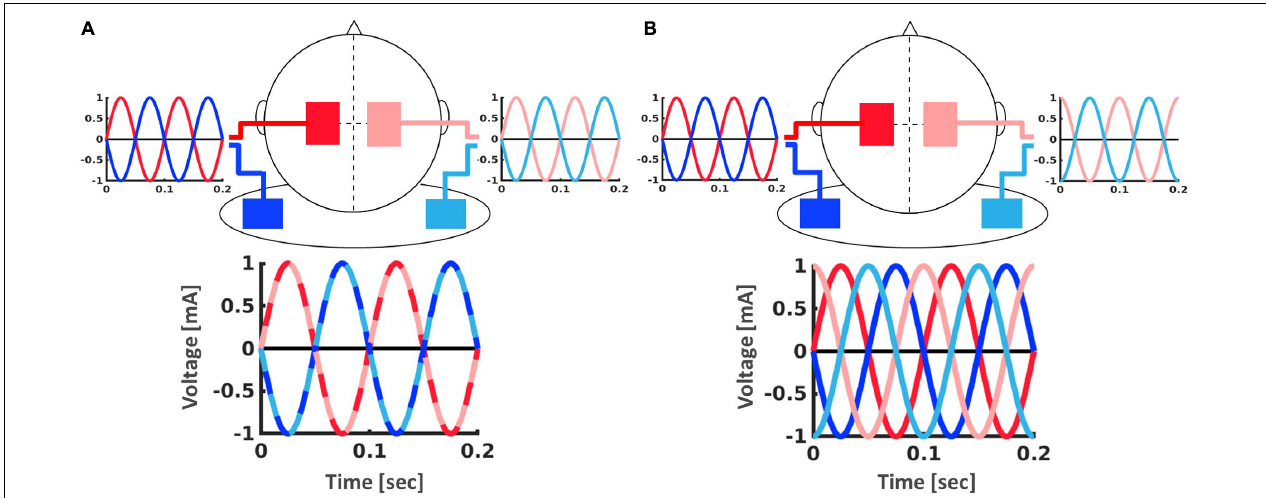
FIGURE 2 | Setup for the tACS application with two stimulators (dark and light) which were each connected to one electrode over M1 (red) and one electrode on the ipsilateral shoulder (blue). (A) In-phase stimulation (0 ◦ phase shift between hemispheres). (B) Out-of-phase stimulation (90 ◦ phase shift between